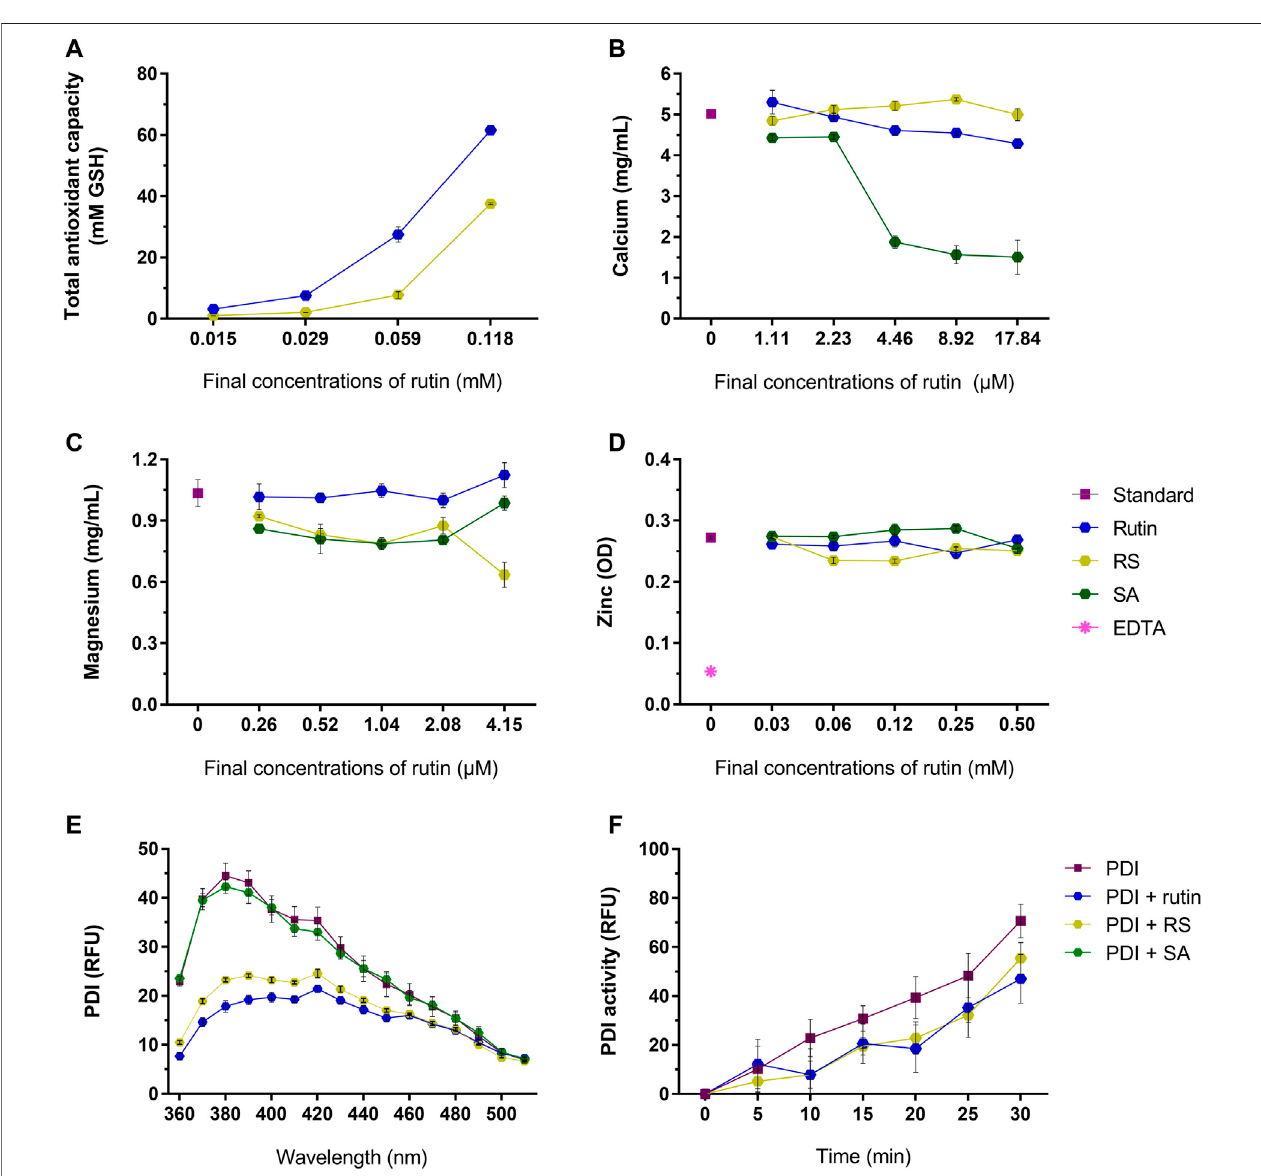
FIGURE4 |(A) Total antioxidant capacity ofrutin and RS at different concentrations, analyzed by theCUPRACmethod. Data wereexpressed asGSHequivalents (mM). Quenching of (B) calcium, (C) magnesium and (D) zinc by the pre-incubation with rutin, RS, SA or Na 2 EDTA at different concentrations. Data were expressed as concentration of free calcium or magnesium (mg/ml) or as optical density units (OD) for zinc. (E) Fluorescence spectra of PDI or PDI pre-incubated with rutin, RS or AS. Data were expressed as relative fl uorescence units (RFU). (F) PDI reductase activity, evaluated by change in the fl uorescence of di-eosine-GSSG probe (150 nM); PDIwastestedaloneorPDIpre-incubated withrutin,RSandSA(60 µM).Datawereexpressedasrelative fl uorescenceunits(RFU).Assaysfor (A – D) werecarriedoutin duplicate and for (E,F) in